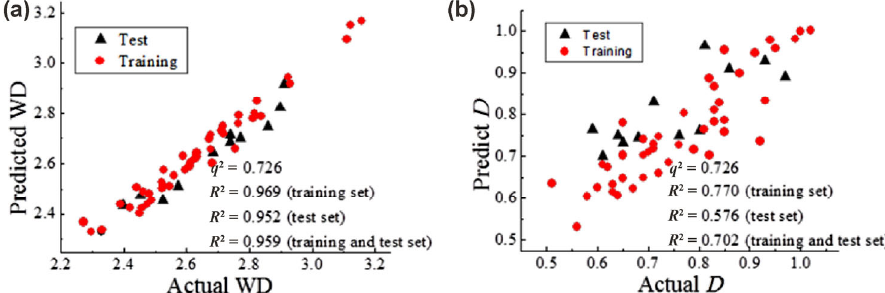
Fig. 1 Plots of the actual versus the predicted values of WD (a) and D (b) obtained by CoMFA model for the training and the test set of